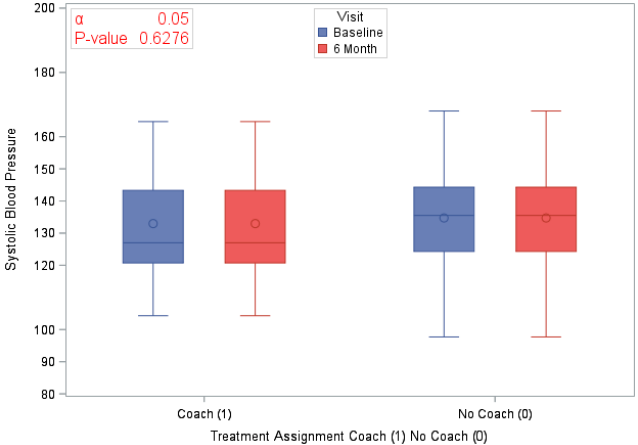
Figure 4. Systolic blood pressure by study visit and randomization group.